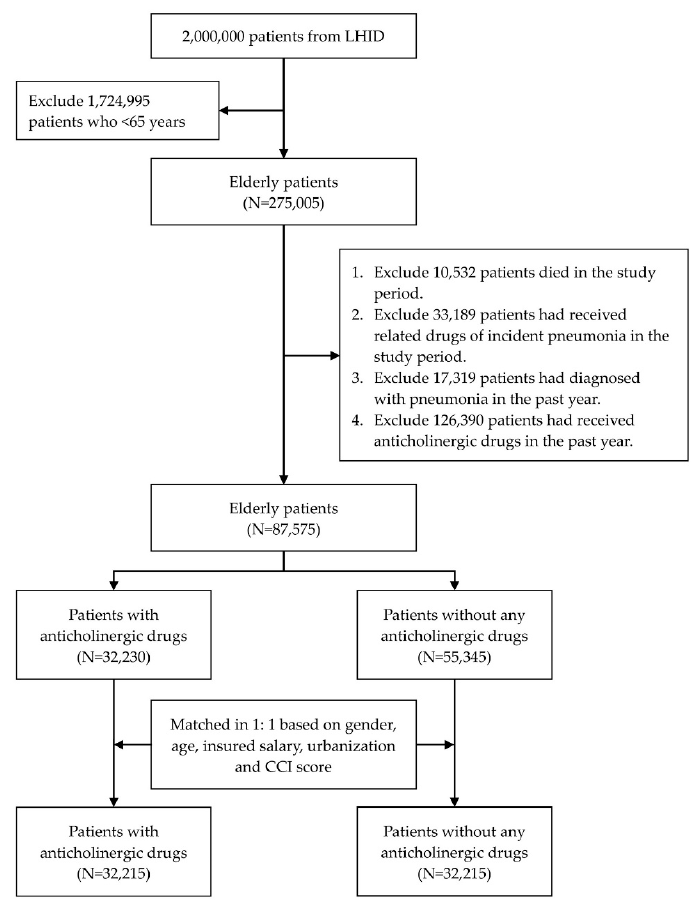
Figure 1. Flowchart of the study subject selection process. (Abbreviations: LHID, longitudinal health insurance database; CCI, Charlson comorbidity index)